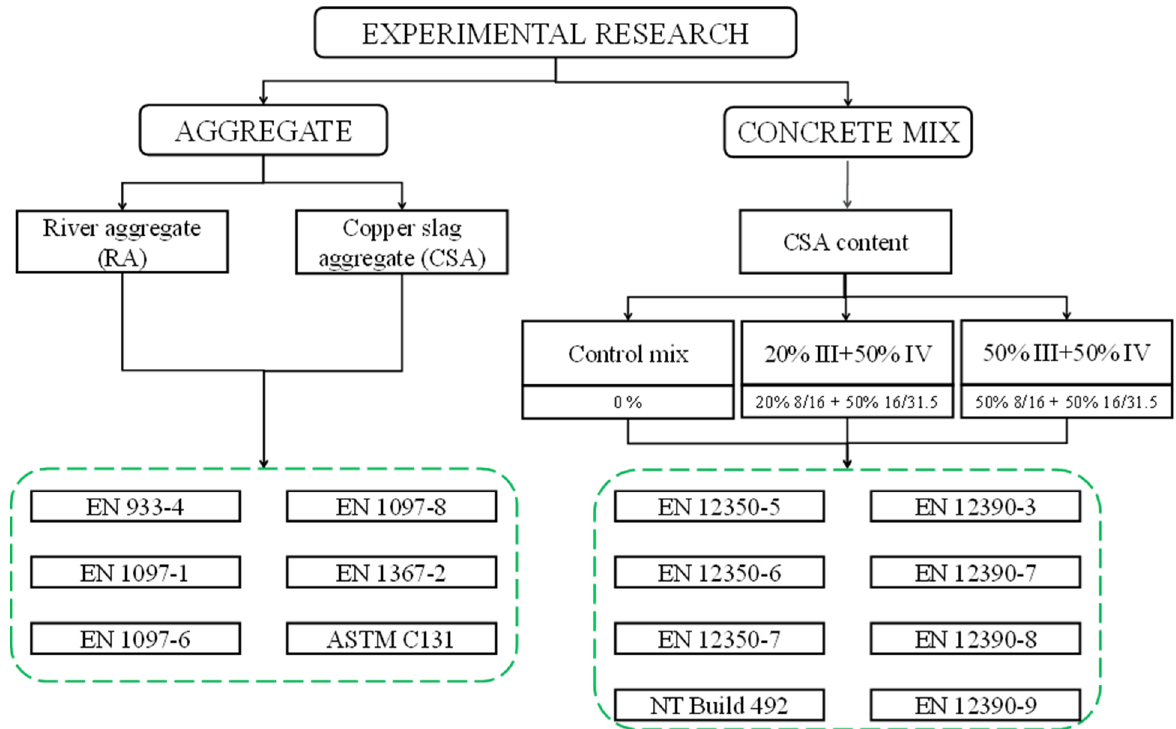
Figure 3. Diagram of testing methods for aggregates and concrete mixtures.